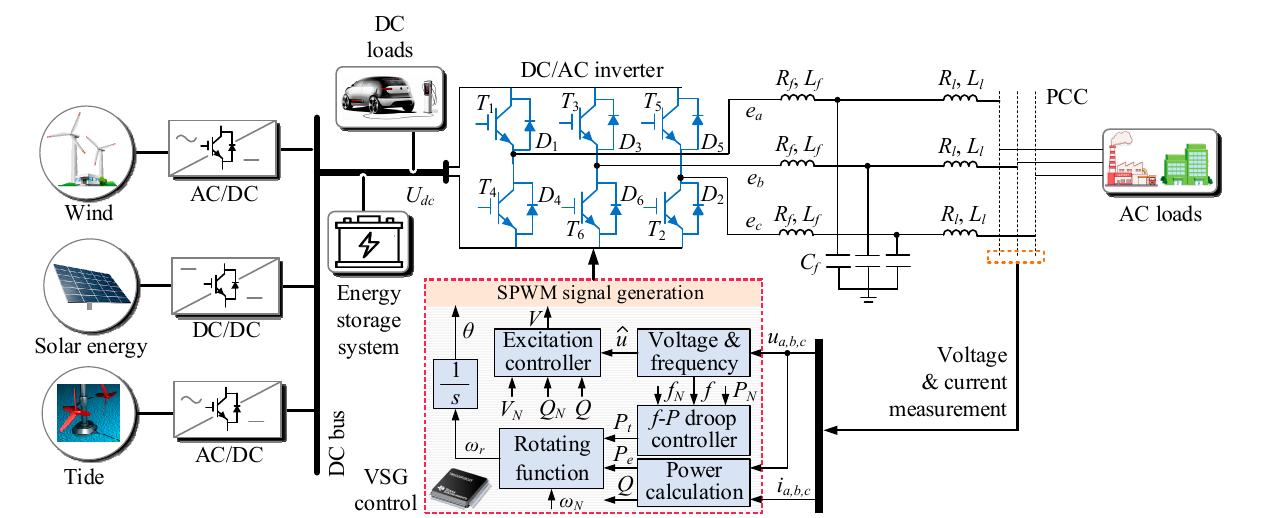
Figure 1. Structure of VSG control-based microgrid.